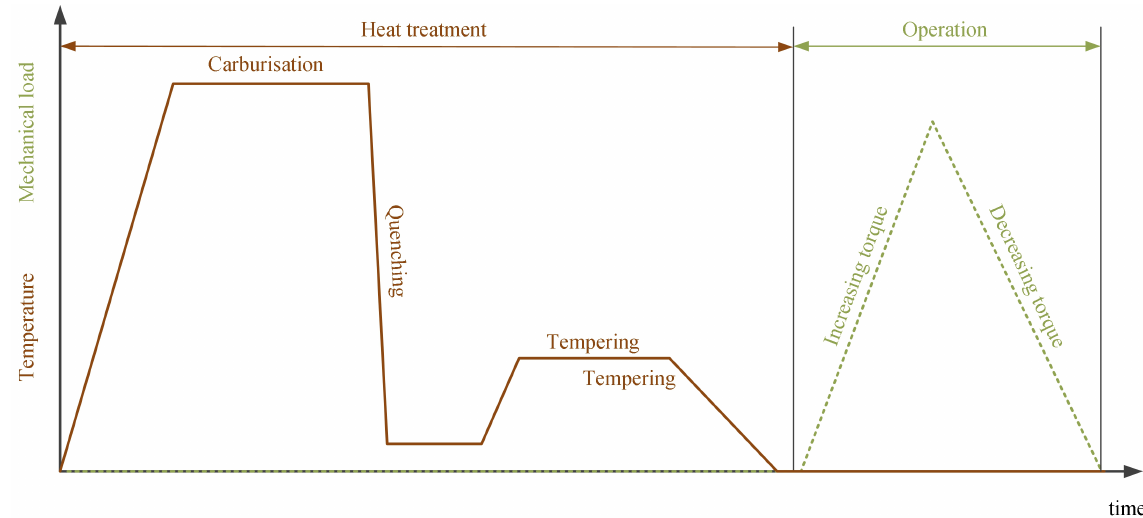
Figure 2. The timeline of the heat treatment process and the typical